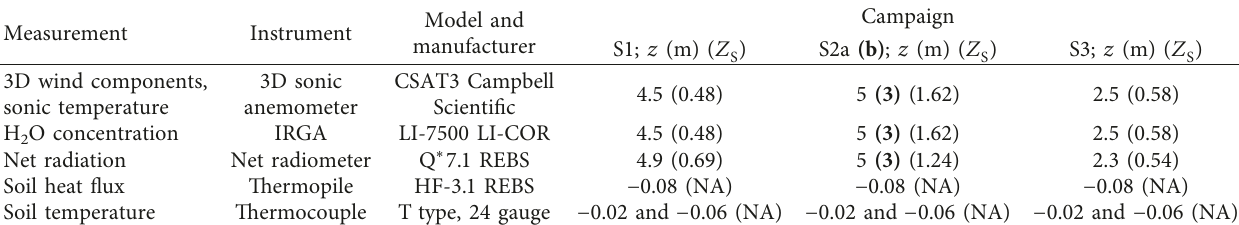
Table 1: Instruments, their heights, and normalized heights in the 3